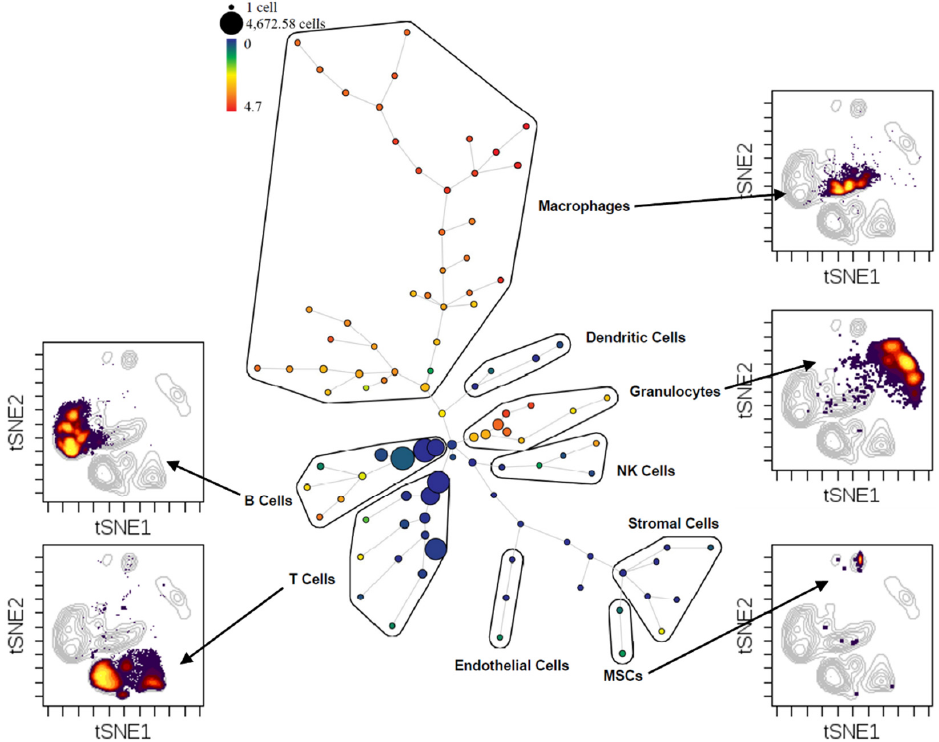
Figure 2. SPADE tree with contour viSNE plots to show heterogeneity of different cell populations within the critical ‐ size bone defect site.